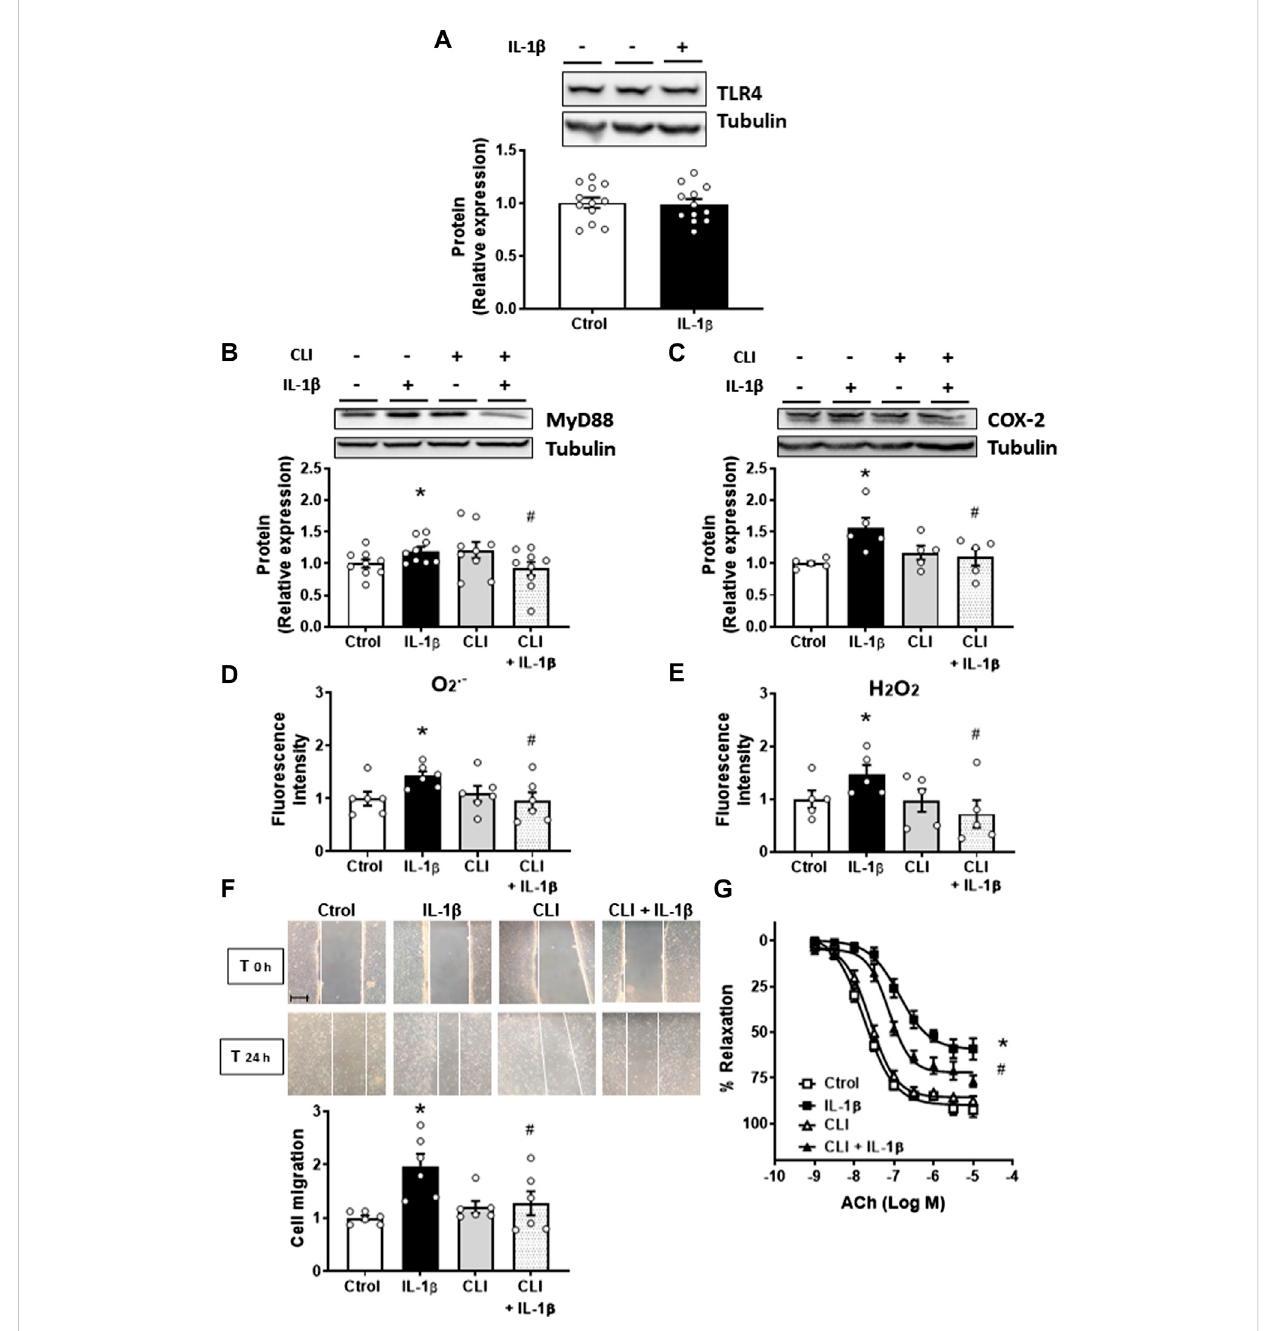
RoleofTLR4 pathwayon theIL-1 β -inducedeffects. Effect ofInterleukin-1 β (IL-1 β ,10 ng/mL) on TLR4 expression (A) . Effect ofCLI-095 (1 µM),IL-1 β and CLI-095 + IL-1 β on myeloid differentiation factor 88 (MyD88) and cyclooxygenase-2 (COX-2) protein expression (B,C) . Effect of CLI-095 on IL-1 β - induced superoxide anion (O 2 .- ) and hydrogen peroxide (H 2 O 2 ) production evaluated by fl ow cytometry (D,E) and cell migration (F) in vascular smooth muscle cells. Representative blots are shown in upper panels. Images of cell migration by wound healing assay are included; bar scale represents 50 μ m. * p < 0.05 vs. control; # p < 0.05 vs. IL-1 β by Student ’ s t -test ( n = 5 – 12). Effect of CLI-095, IL-1 β and CLI-095 + IL-1 β on acetylcholine (ACh)- induced relaxation inmice aorticsegments precontracted with phenylephrine (G) . * p < 0.05 vs.control; # p < 0.05 vs.IL-1 β by two-way ANOVA followed by Bonferroni ’ s post test ( n = 5). See methods for the incubation